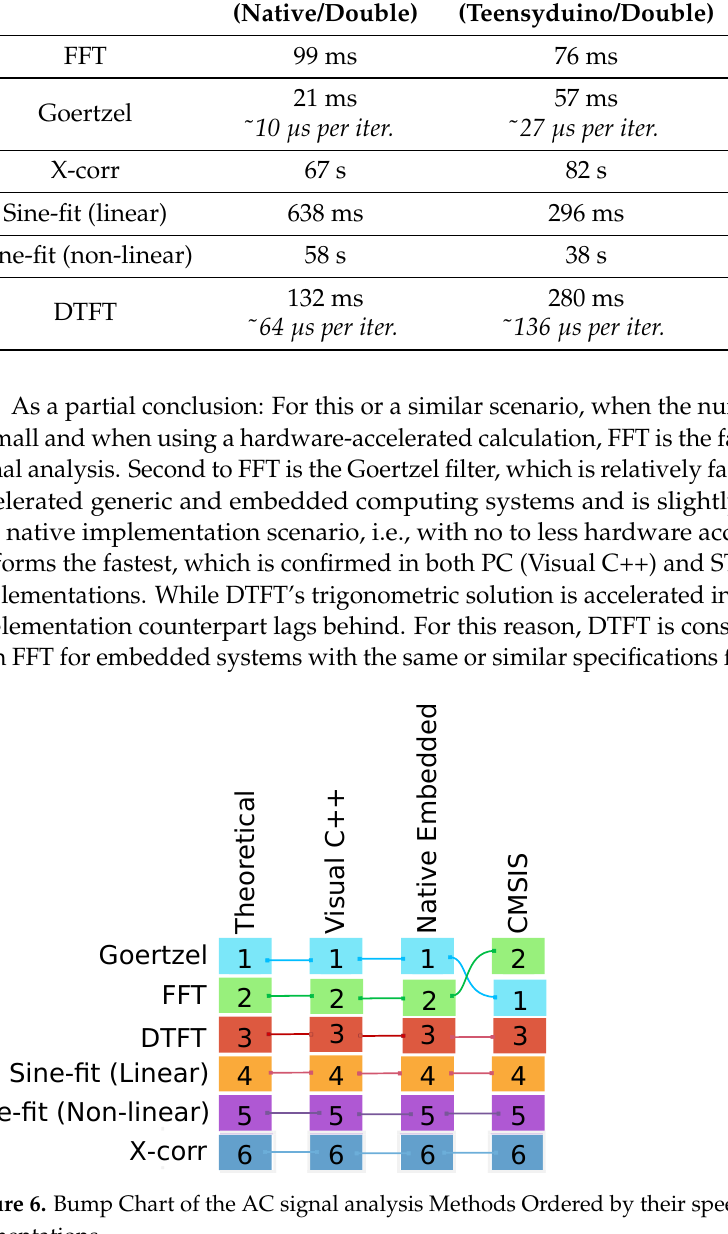
Table 9. Sorted from highest to lowest memory requirements, non-linear least squares